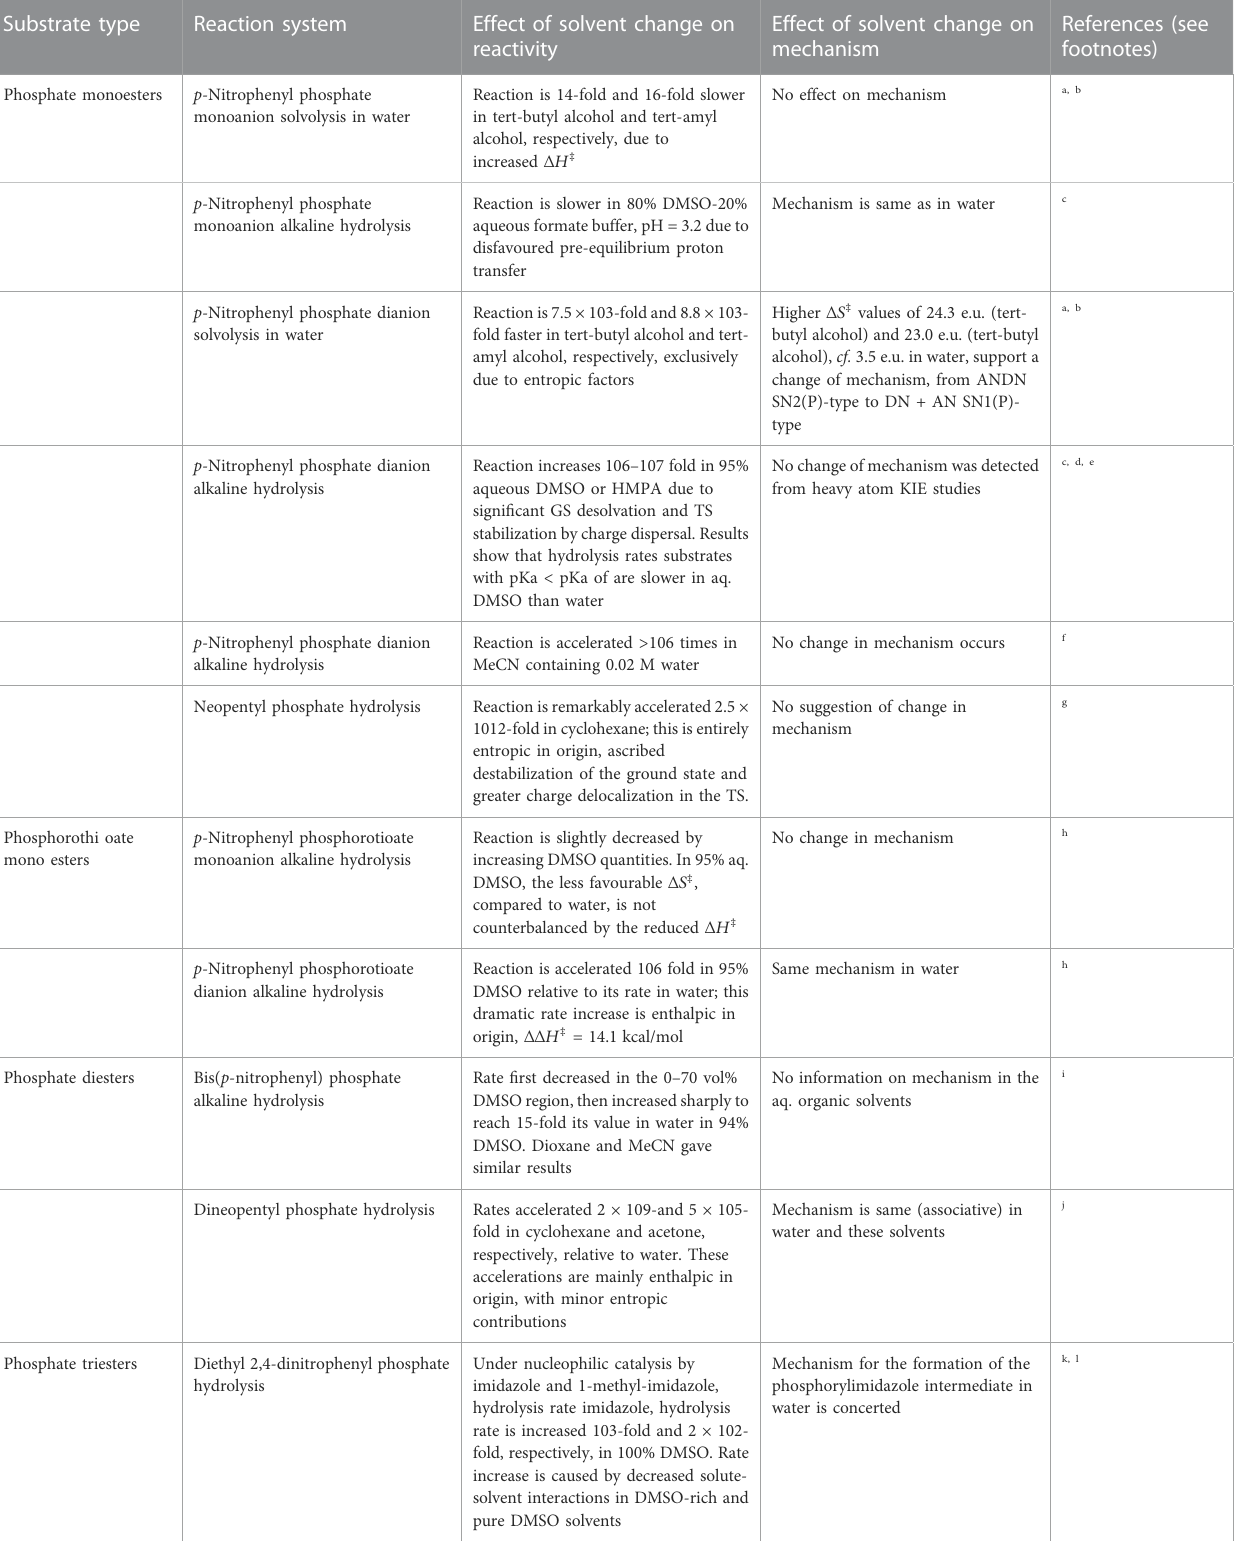
TABLE 5 A summary of the effects of solvent change on reactivities and mechanism in some of the different reaction systems encountered in phospho group transfers. Substrate